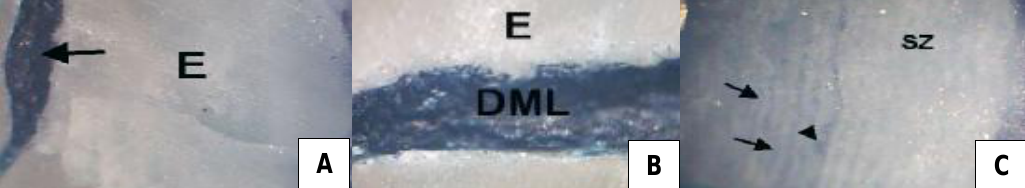
Figure 4: Group C. A..View for enamel surface (E) shows opaque area of minerlization and a lesion (arrow) shows blue stains Ground X4. B.. Magnifying view for figure B shows enamel (E) and deminerlized lesion (DML).X10 C..Surface morphology of tooth enamel treated with stannous flouride shows smooth zone (SZ), fine porosities (arrow head, and occasional fine fissuring (arrows).X4